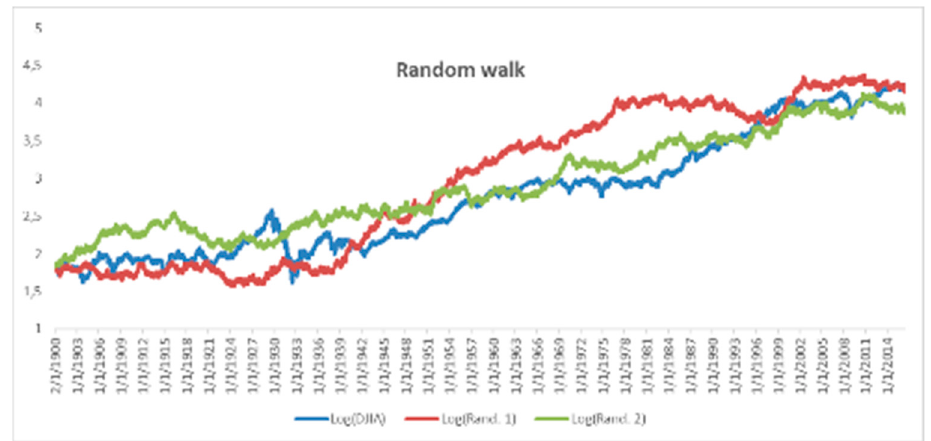
Figure 12. DJIA compared to randomly generated series. Source: Authors’ processing is based on data available on http://stooq.com/ (accessed on 20.07.2017).